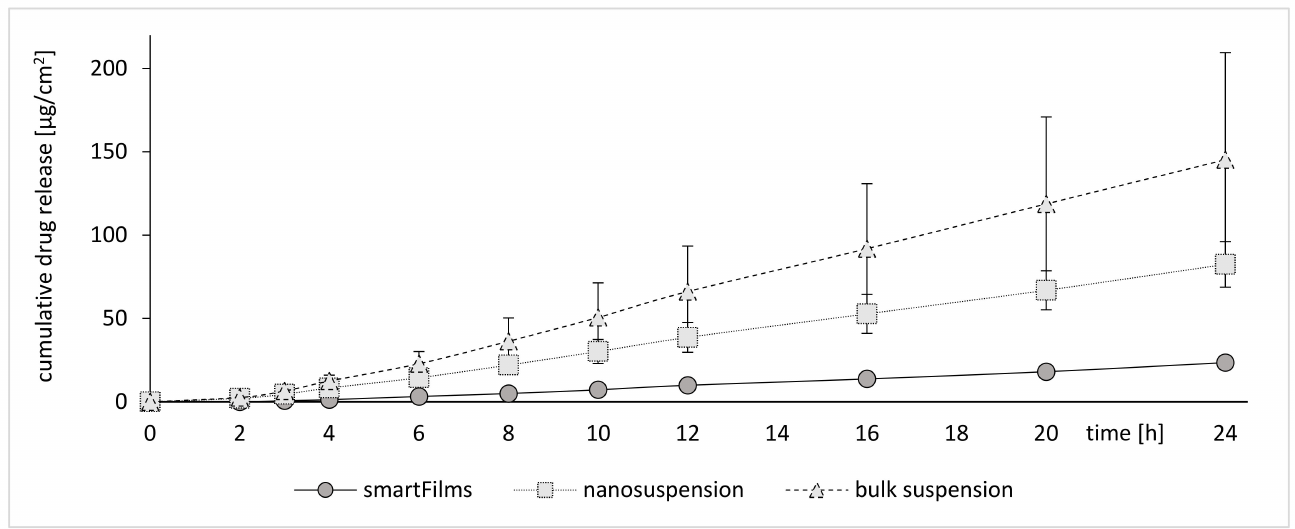
Figure 7. In vitro Franz cell diffusion tests to determine the passive diffusion of curcumin from smartFilms and the benchmark controls (curcumin bulk and